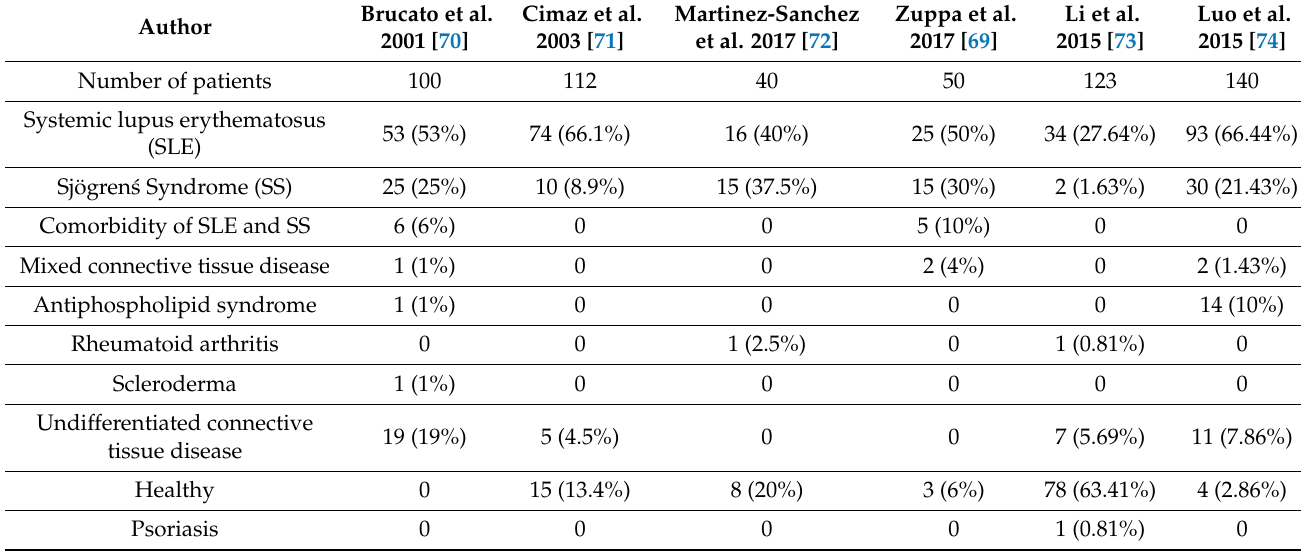
Table 2. Clinical picture of SS-A-positive mothers who gave birth to children with symptoms of neonatal lupus (number of